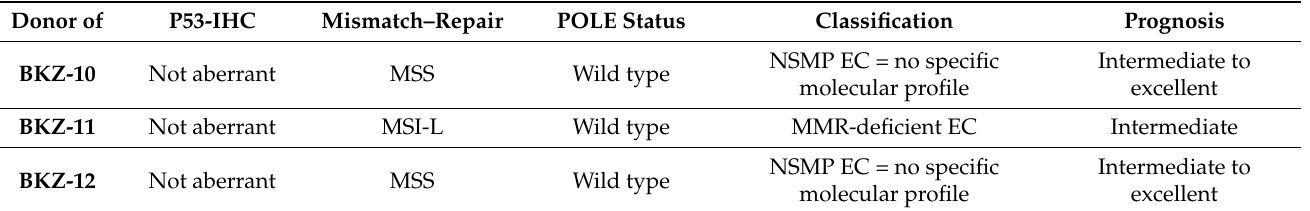
Table 1. Molecular classification of parental endometrial adenocarcinomas. IHC =